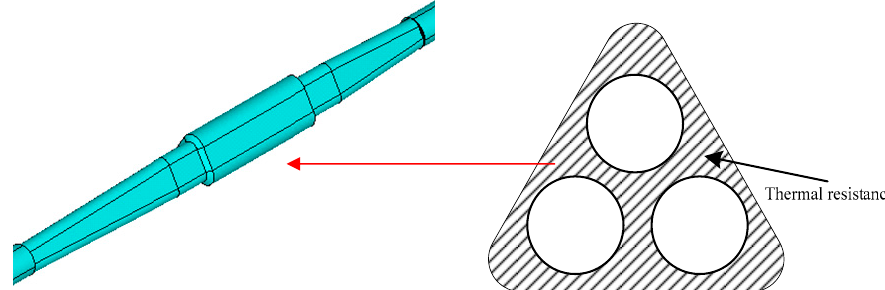
Figure 14. The model and irregular thermal resistance in this paper.